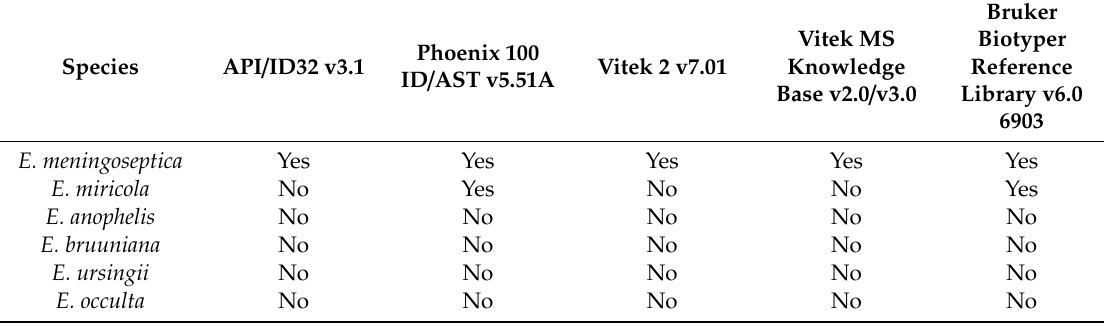
Table 2. Thecoverageofthereferencedatabaseoffivecommoncommercialmicrobialidentificationsystems.